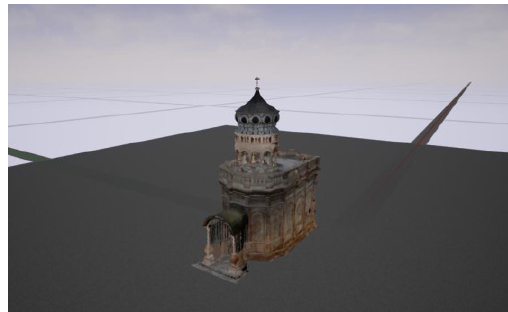
Figure 6 . The final placement of the 3D model inside the